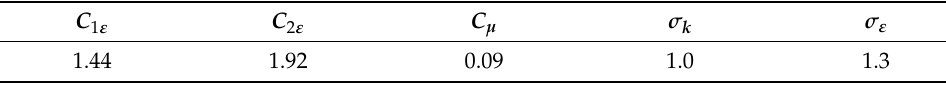
Table 2. Coefficients for the standard k- ε turbulence model.